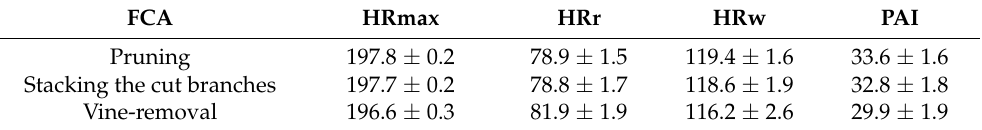
Table 5. The classification of PAI by %HRR.